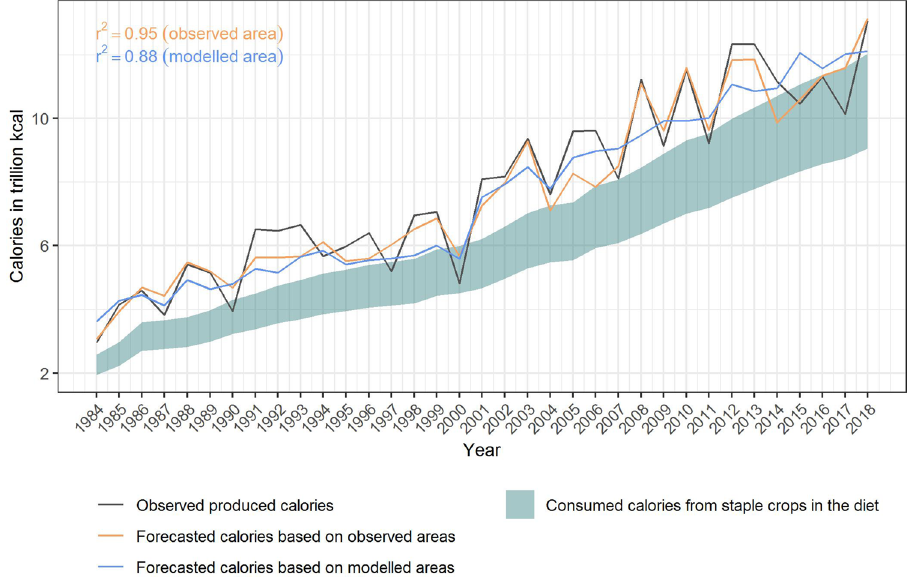
Figure 3. Hindcast performance of aggregated nationally produced calories from staple crops (maize, sorghum and millet) compared to the usually consumed calories from those crops in Burkina Faso. The black line shows the observed produced calories minus post-harvest losses and the bran. The forecast is provided for two cases: (1) harvest areas are known (yellow line), (2) harvest areas are not known and modelled instead (blue line). The band shows the range between the lowest and the highest share of calories from maize, sorghum and millet from 1984 to 2018 in the total supplied calories (i.e. between ca. 47% and 61% of total supplied calories stemmed from maize, sorghum and millet in the past in Burkina